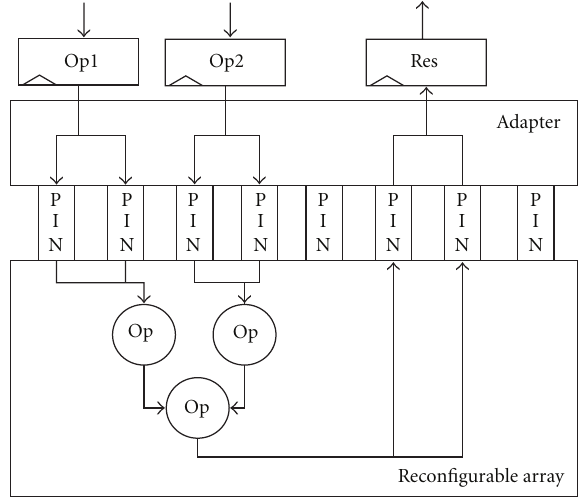
Figure 6: RFU is interfaced with the processor registers through an